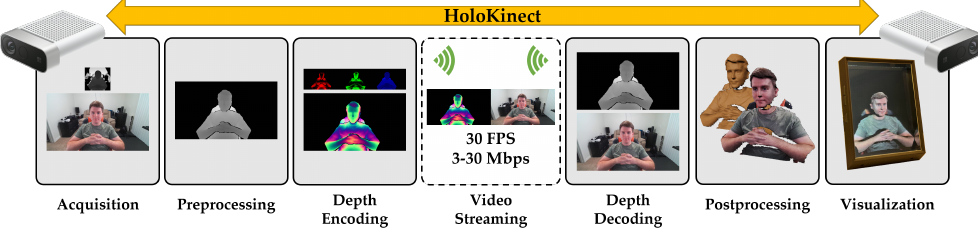
Figure 1. HoloKinect, an end-to-end solution for 3D video conferencing with a simulated holographic effect. The current implementation uses a Microsoft Azure Kinect for RGB-D capture and a Looking Glass Portrait multiscopic display for 3D visualization at each end of the live two-way video confer- ence. The implementation is highly modular and easily facilitates alternative RGB-D capture systems (e.g., iPhone TrueDepth sensor) or 3D display technologies (e.g., VR/AR head-mounted